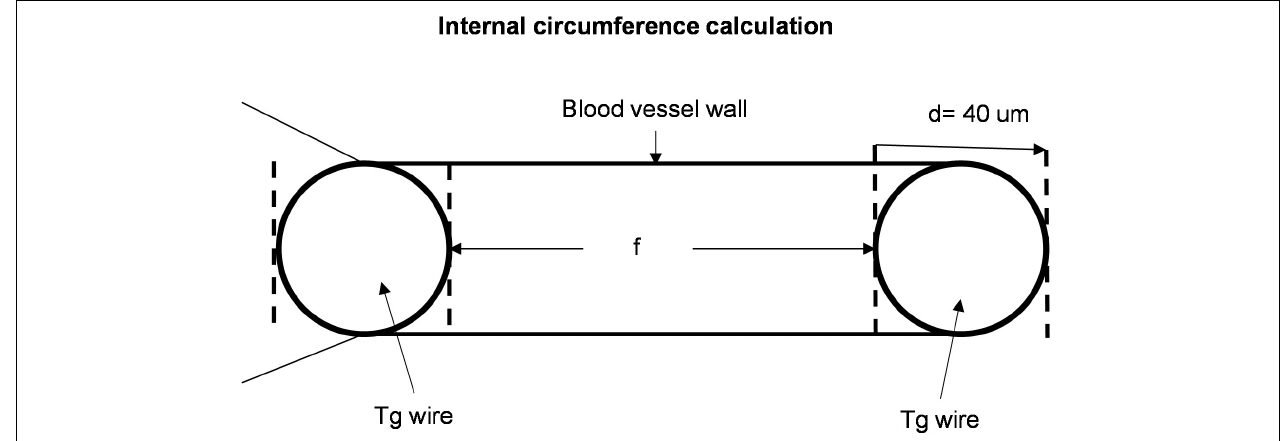
FIGURE 1 | Measurement of the internal circumference. f, distance in µ m between the inner edges of the wires; tg wire, tungsten wire; d, diameter of the wire. Internal circumference (L) is given by: L = ( π + 2)d +